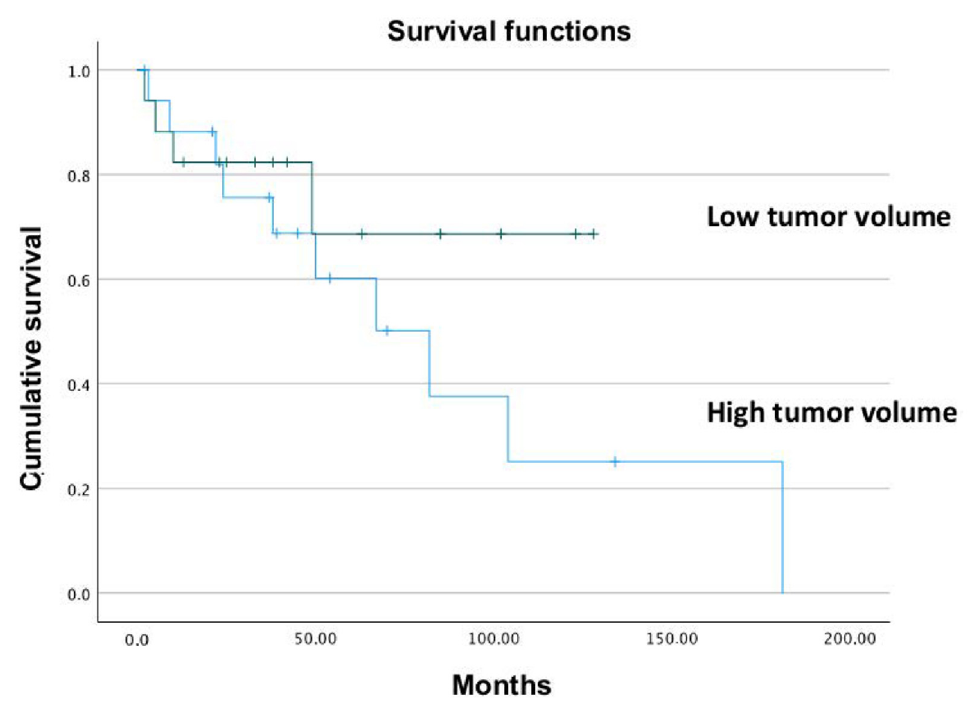
Figure 3. The mean survival time of patients with higher chondrosarcoma volume was lower but not significant.